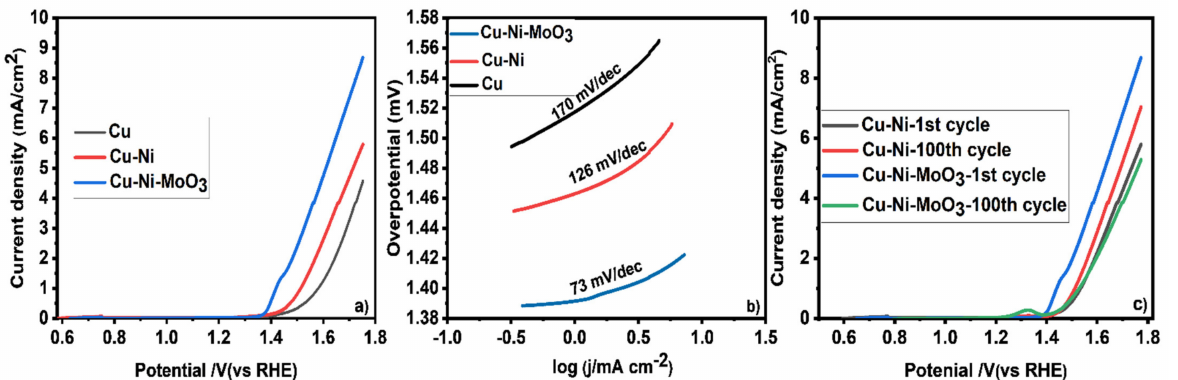
Figure 6. OER catalytic performances of three different electrodes in 0.1 M KOH electrolyte ( a ); Over potential of different electrodes ( b ); results of OER before and after 100 cycles ( c ).